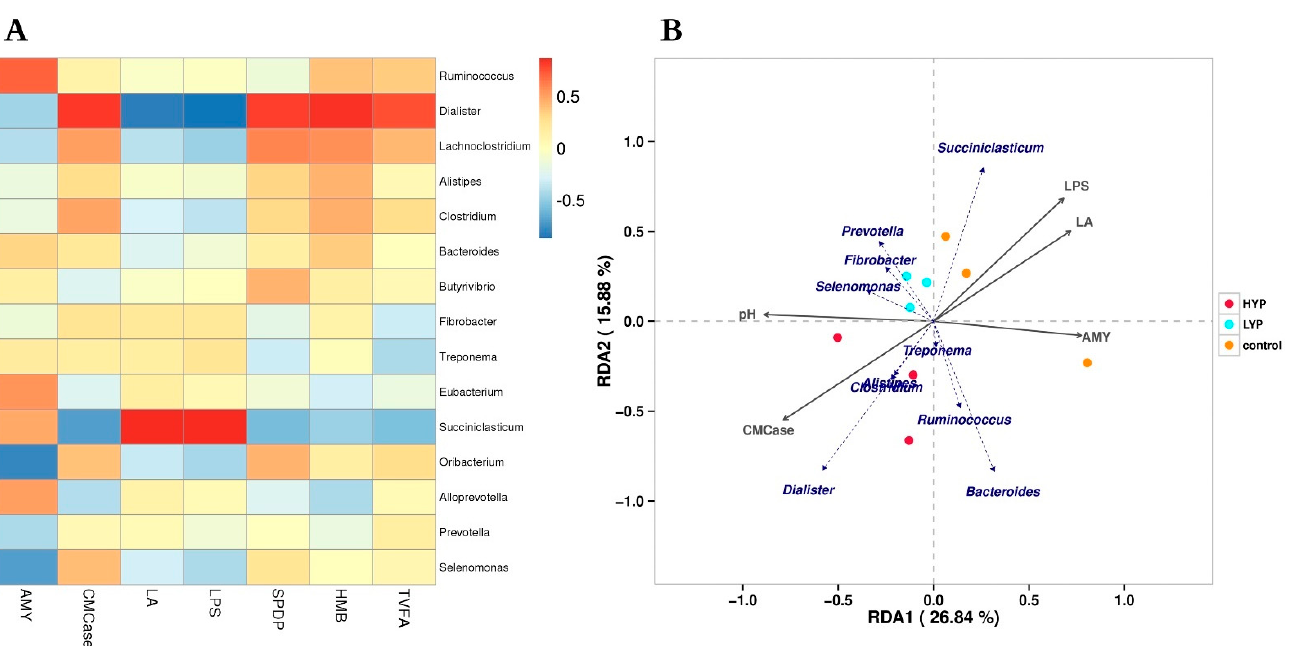
Figure 4. Correlation analyses between the relative abundances of microorganisms and environmental parameters. ( A ) Pearson correlation heatmap differences between digestive enzyme activities, fermentation parameters and microbiota of the solid-associated (SA) system (R > 0.4 or R < − 0.4; p < 0.05). ( B ) RDA/CCA analysis of the top 10 genera of the SA system and five rumen environmental factors. The relationship between the points of elements in the graph is represented by the distance; the relationship between the rays is represented by the angle, where the obtuse angle represents a negative correlation, and the acute angle represents a positive correlation.